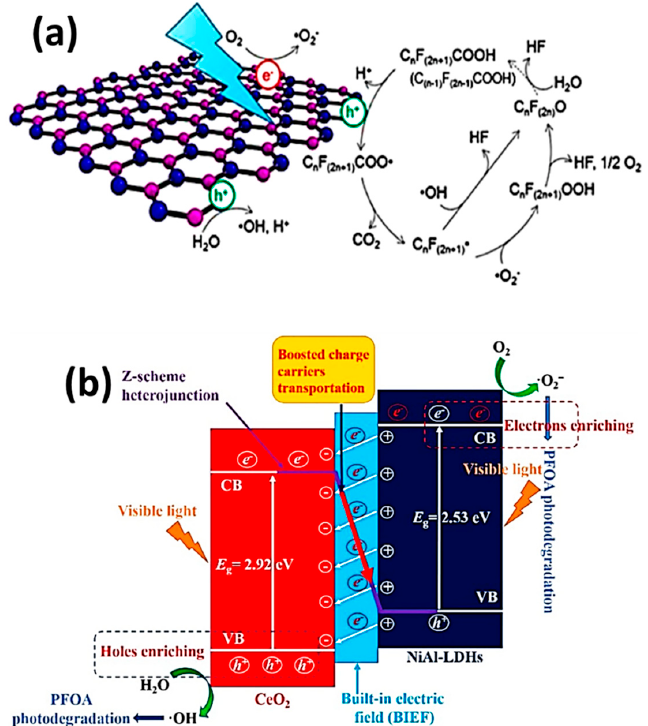
Figure 5. PFOA degradation mechanism over ( a ) boron nitride (reprinted from [97], copyright (2020) with permission from ACS publications) and ( b ) the z-scheme based heterojunction of core–shell CeO 2 @NiAl-LDHs (reprinted from [99], copyright (2021) with permission from Elsevier). Table 1. Heterogeneous photocatalysis applied to PFAS decontamination.